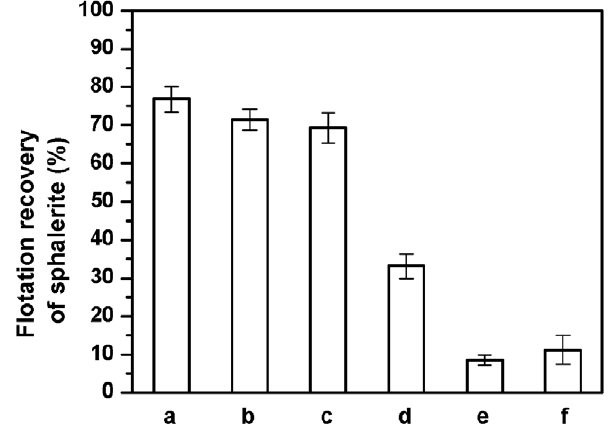
Figure 2. Flotation recovery of sphalerite in the presence of bacterial cells, before and after various enzymatic treatments. a - untreated cells; b - proteinase K treated; c - lysozyme treated; d - phosphate deficient medium; e - purified teichoic acid; f – DNase 1 treated.